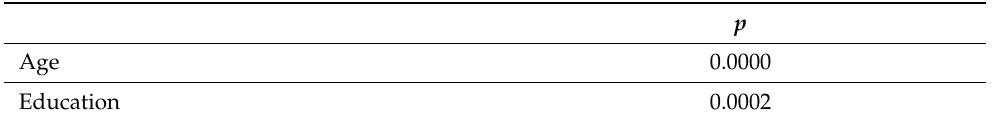
tive of its effectiveness and socio-economic